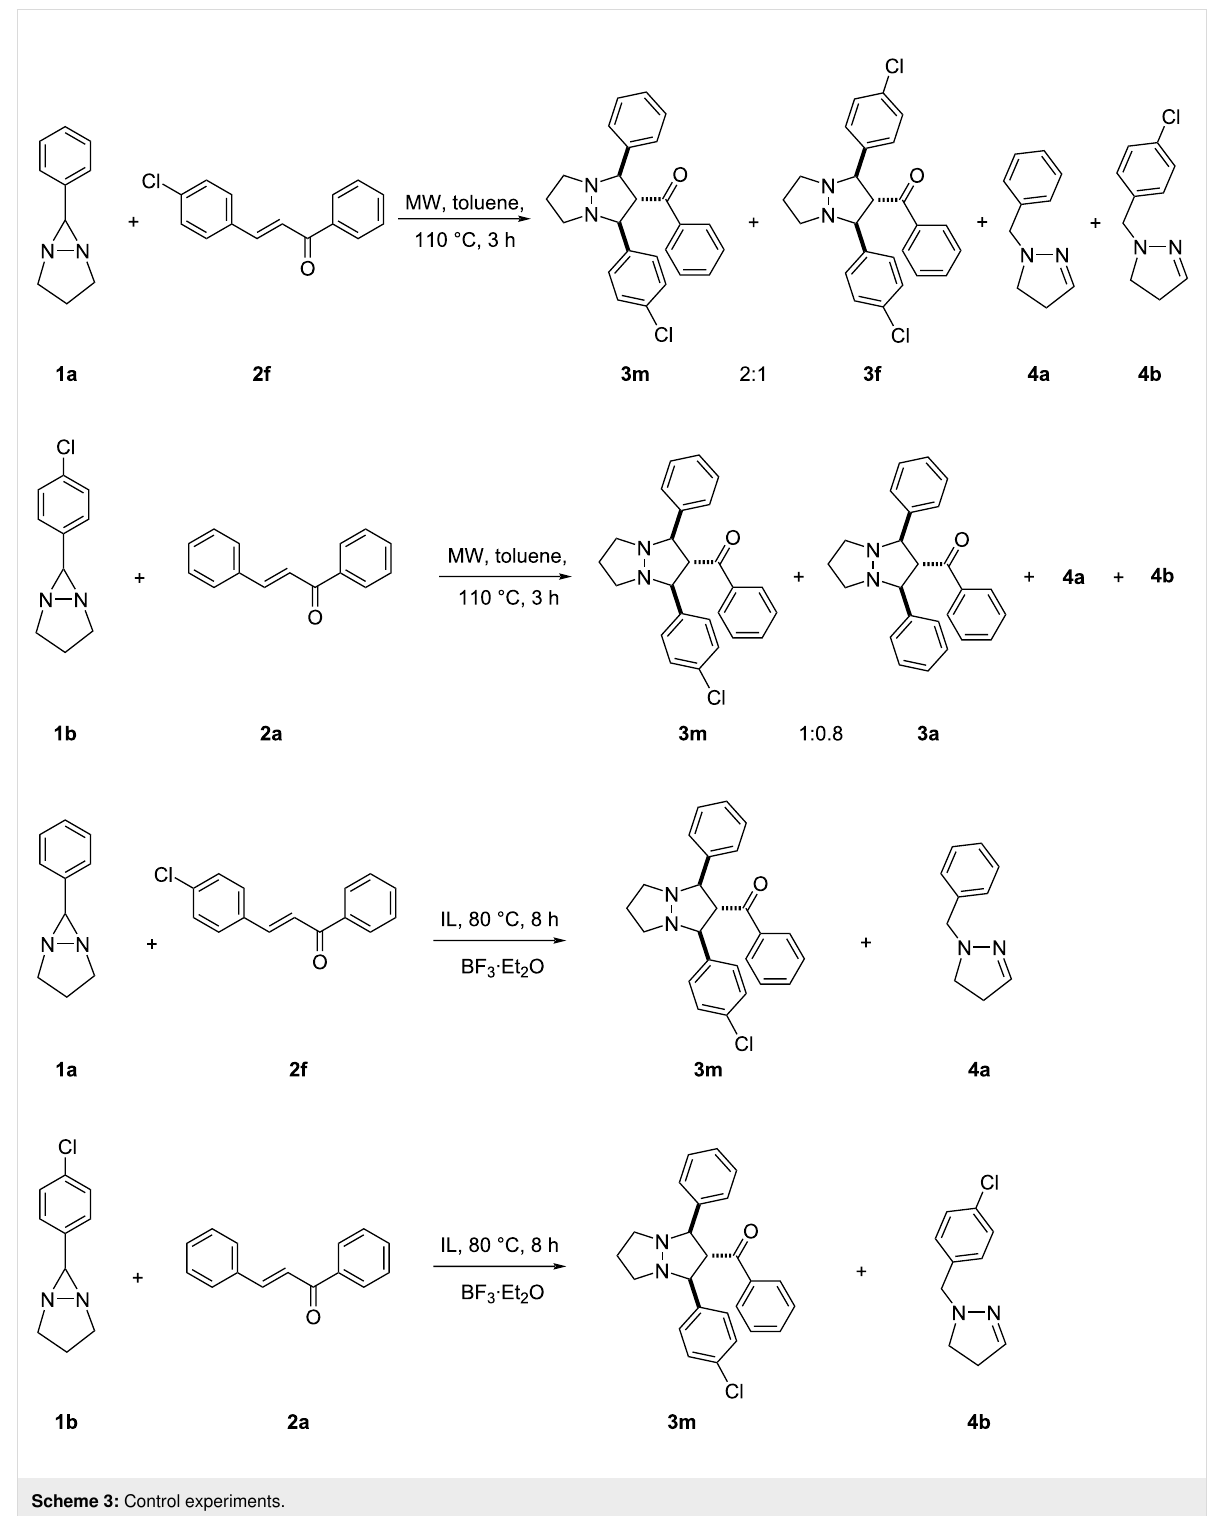
1,3-diarylpropenones occurs regioselective with the formation of 2-benzoyl-substituted pyrazolo[1,2- a ]pyrazoles (Michael- type adducts). For the first time it was shown, that